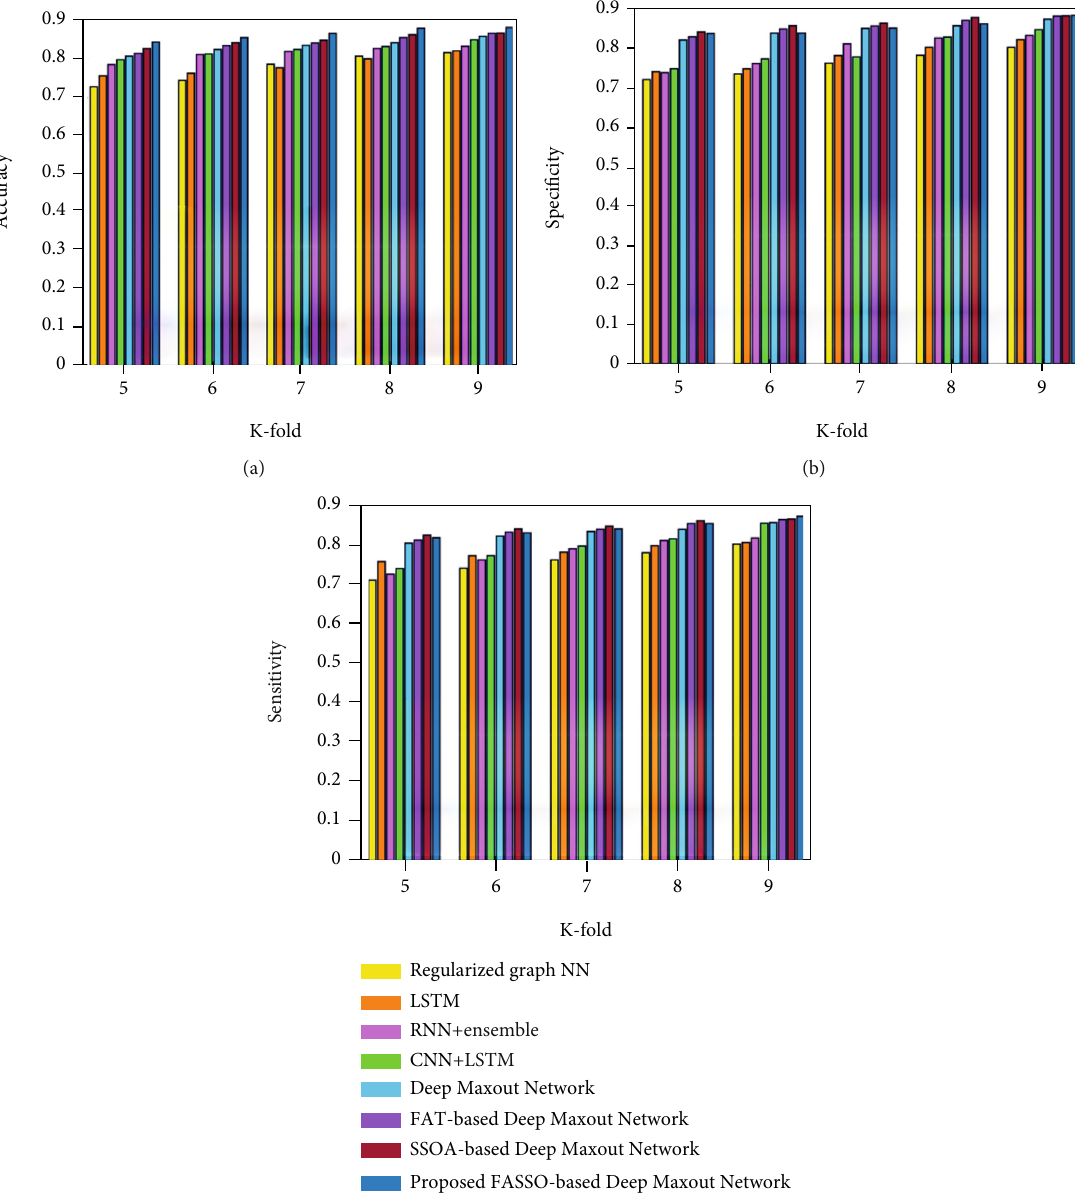
Figure 6: Assessment using K -fold: (a) accuracy, (b) speci fi city, and (c)